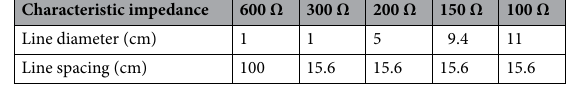
Table 1. Dimensions of balanced transmission